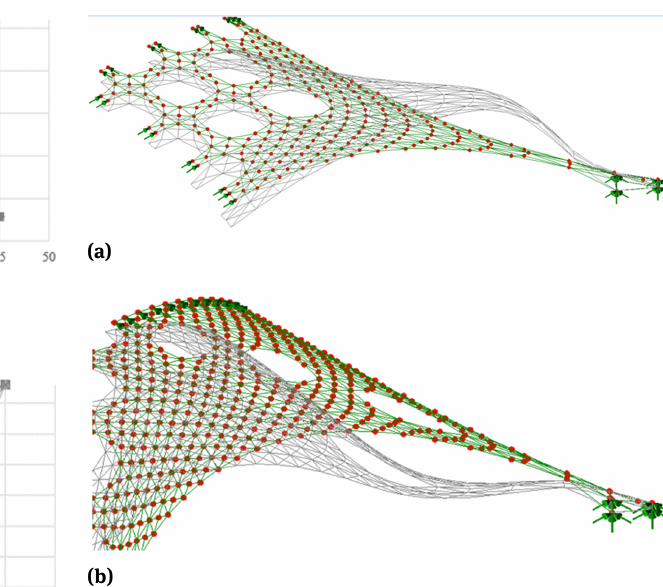
Figure 6: In this figure the collapse modalities of the structure are reported. The first modality “A” represented by far the most frequent one. In this case the cusp of the vault fell down, while the parts near the supports deformed by moving upwards (a). On the other hand, the second collapse modality in reported as the type “B”. It is less frequent, as reported in Figure 5. In this case the cusp of the vault fell down and the parts near the supports deformed